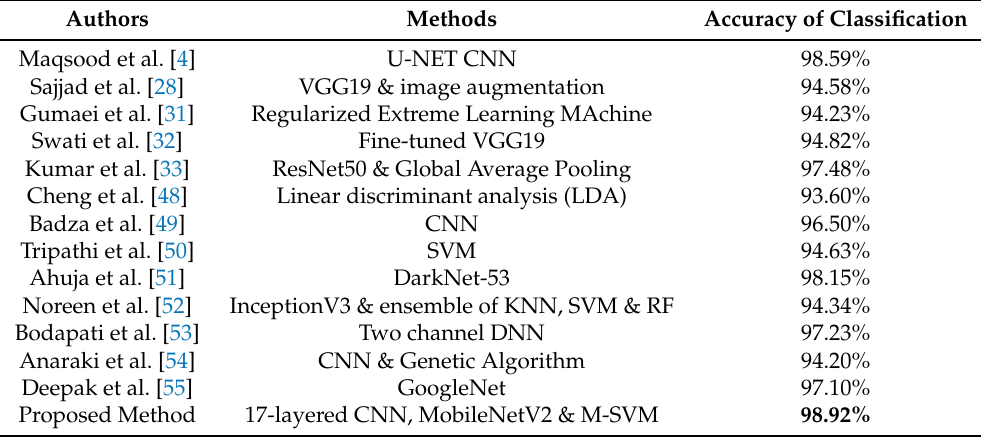
Table 6. Performance comparison with existing